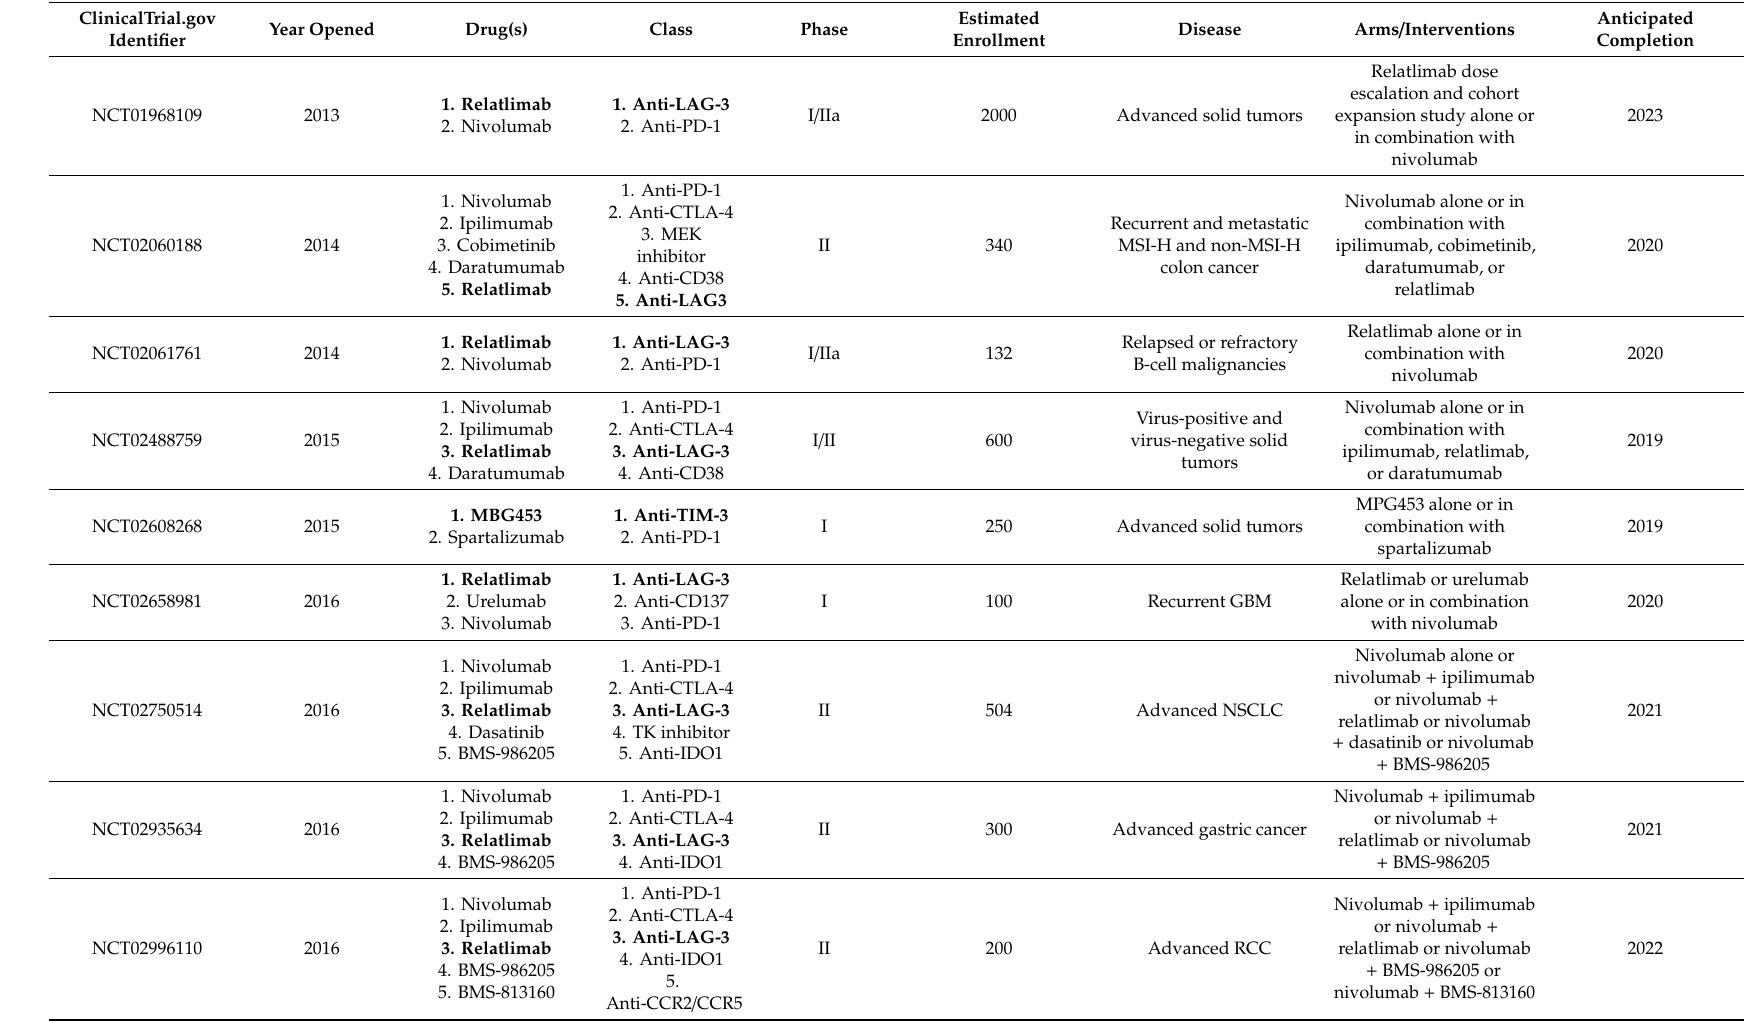
Table A6. Ongoing trials involving anti-LAG-3 and anti-TIM-3 therapies.